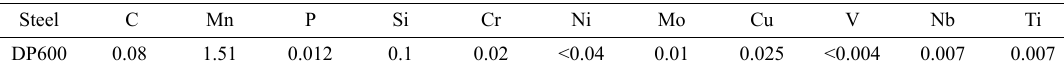
Table 1. Chemical composition (wt%) of the AHSS DP